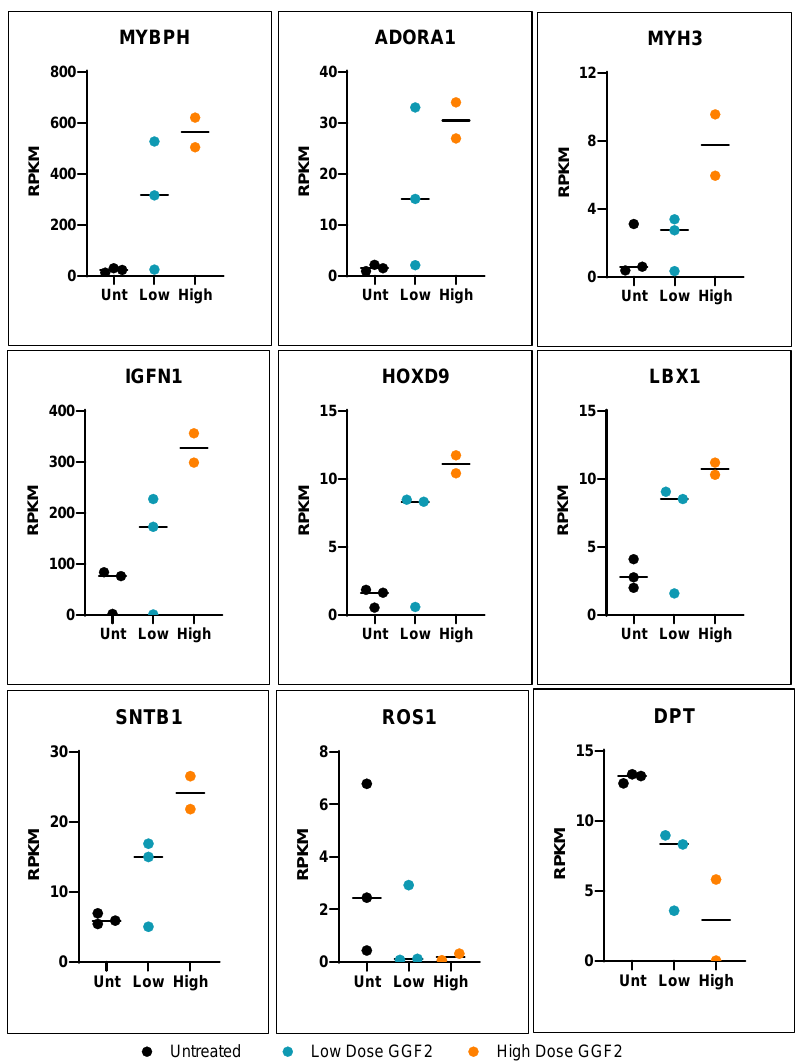
Figure 2. Dose-like response genes altered in GGF-2 treated pigs post-MI. Dot plots show relative counts as reads per kilobase per transcript, per million mapped reads (RPKM) for genes exhibiting fold-differences for GGF2 versus untreated pigs ( y -axis). Individual samples are indicated on the x -axis and by color. Black represents untreated (Unt), teal represents low-dose (0.67 mg/kg/day), and high dose (2 mg/kg/day) is shown in orange.